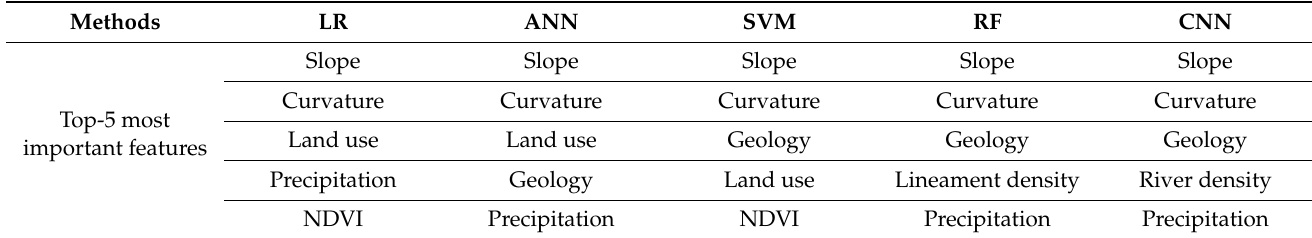
Table 3. Top Five most important features for each